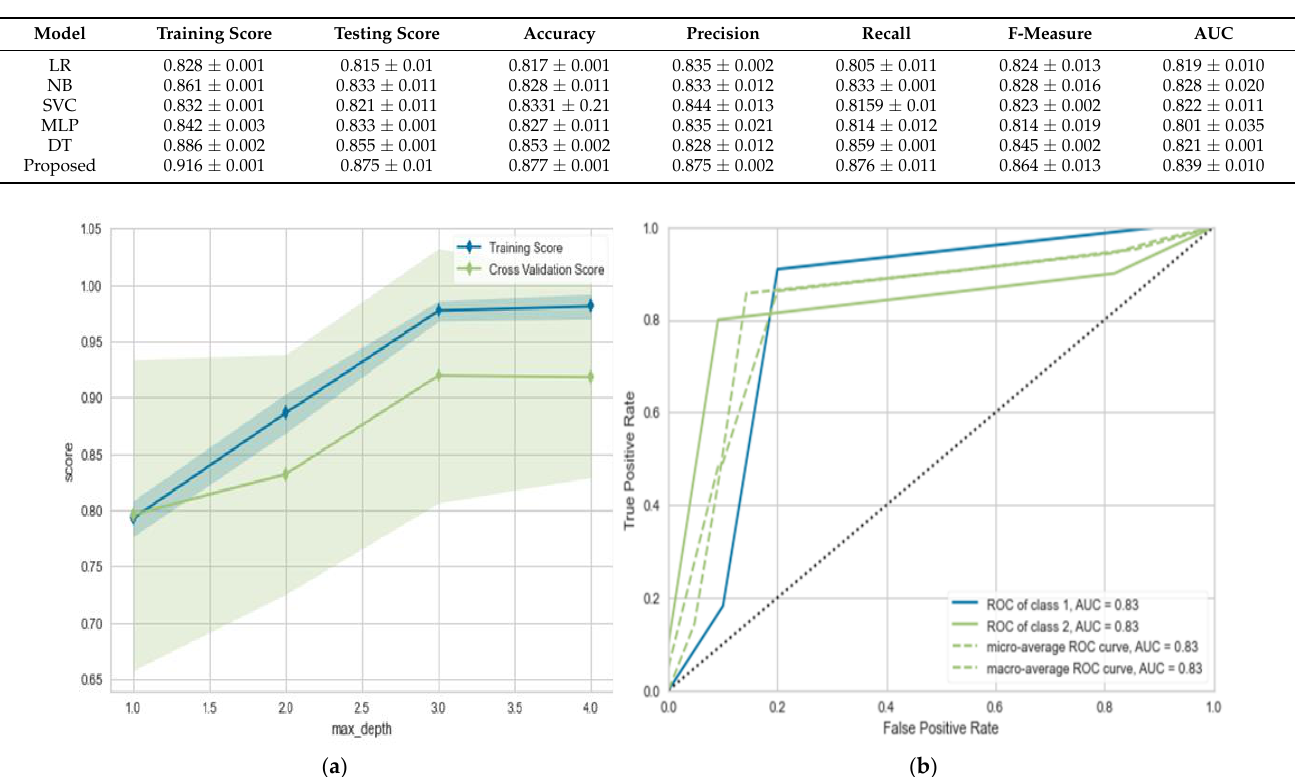
Figure 5. ( a ) Learning curve for the proposed model; ( b ) validation curve for proposed model (prognosis after 1 month).